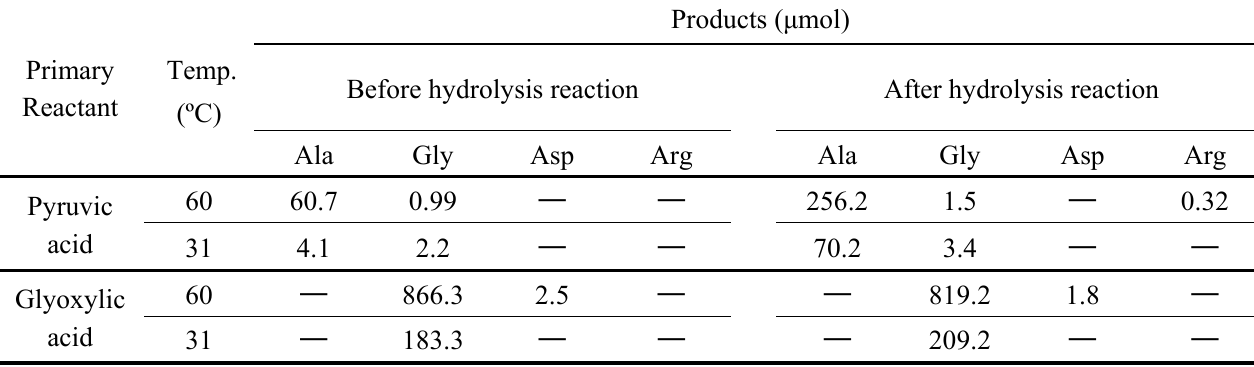
Table 1. Products obtained from keto acids and hydroxylamine in supercritical conditions (60 ºC) or subcritical condition (31 ºC) before/after hydrolysis